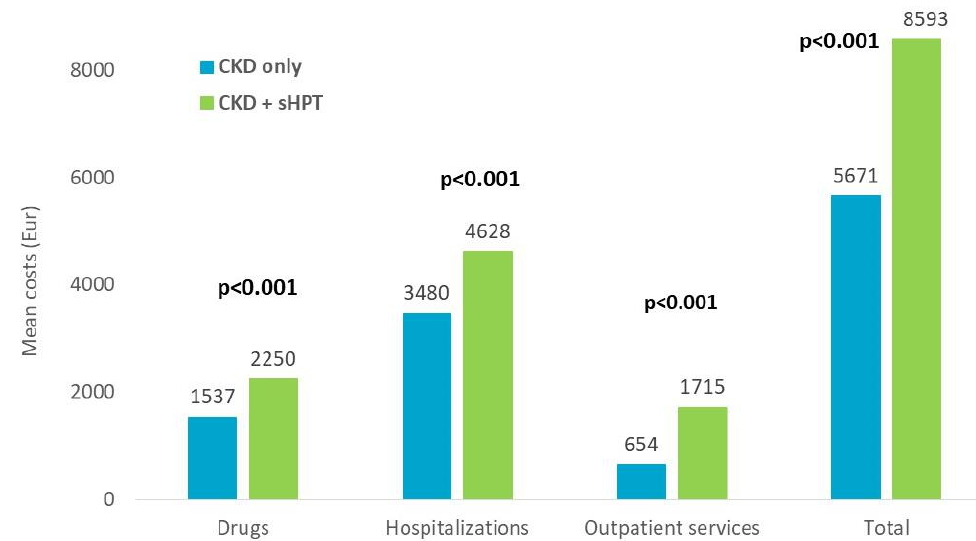
Figure 7. Direct total healthcare costs during the first year of follow up, index-date excluded, post PSM.